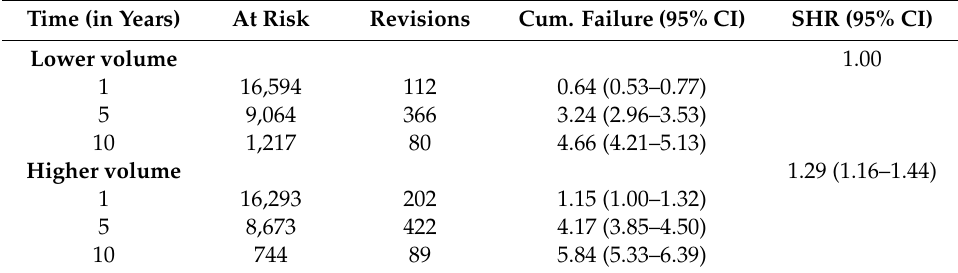
Table 4. Cumulative revision and differences by hospital volume of procedures by year in total knee arthroplasty (TKA). RACat 2005–2016.